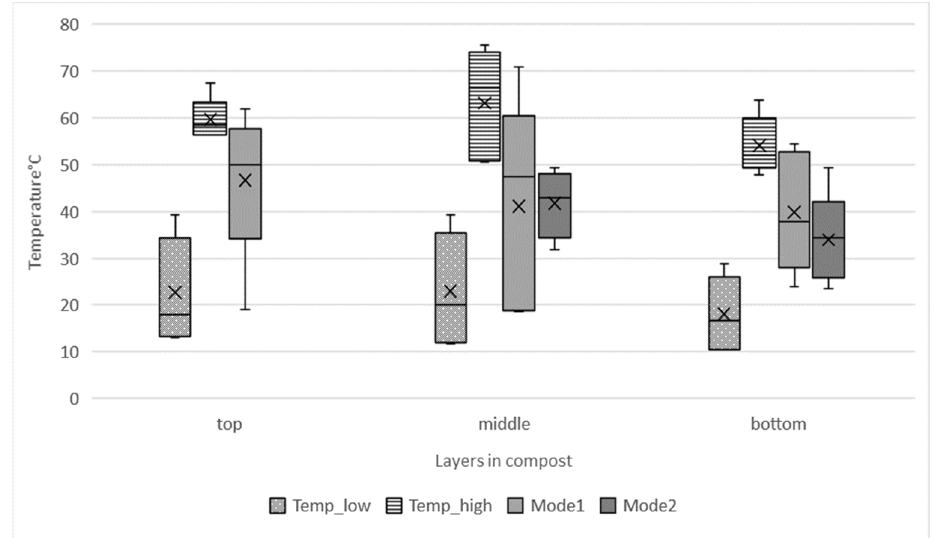
Figure 5. Temperature variation between layers (top, middle and bottom) in windrow (A11, A12, A2) and tunnel (T1, T2) composting experiments. Each layers loggers lowest and highest tempera- tures (Temp_low, temp_high) were measured as well as mode (mode 1–2) variations between treat-